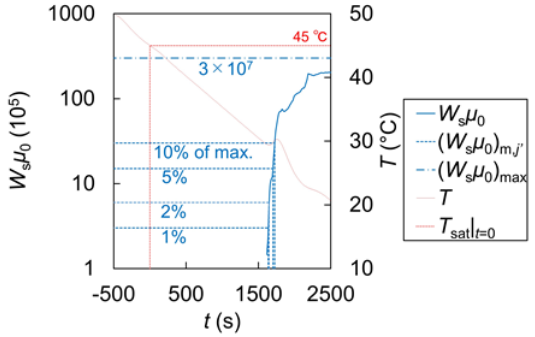
Figure 3. The data acquisition of the latent periods in the main experiment. The total crystal number is denoted by the blue solid line, the thresholds of the total crystal number by the blue dashed line, the maximum total crystal number by the blue chain line, the solution temperature by the red solid line, and the initial temperature by the red dotted line.